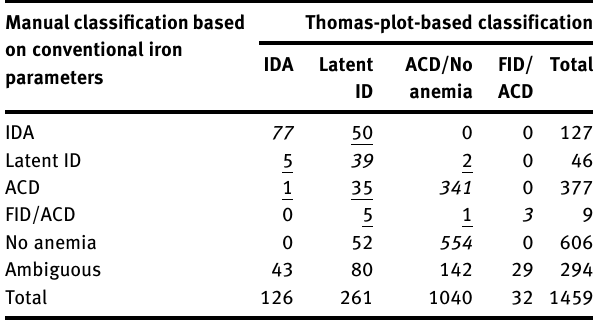
Table  : Cross tabulation comparing the manual and automatic classi fi cation based on the TP.